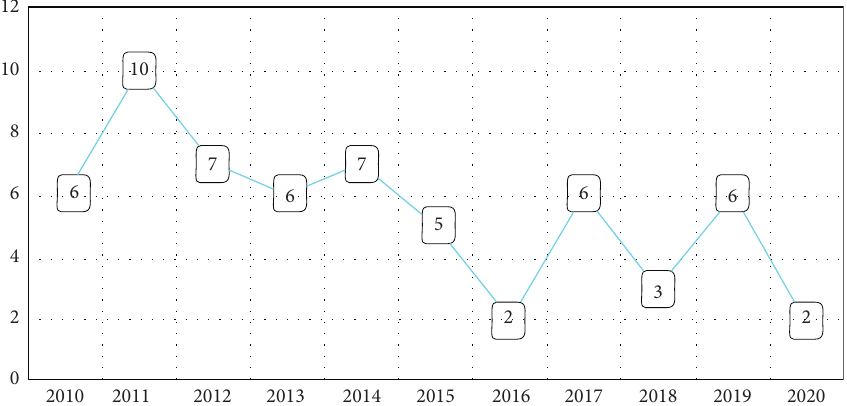
Figure 10: Statistics of the included papers by publication